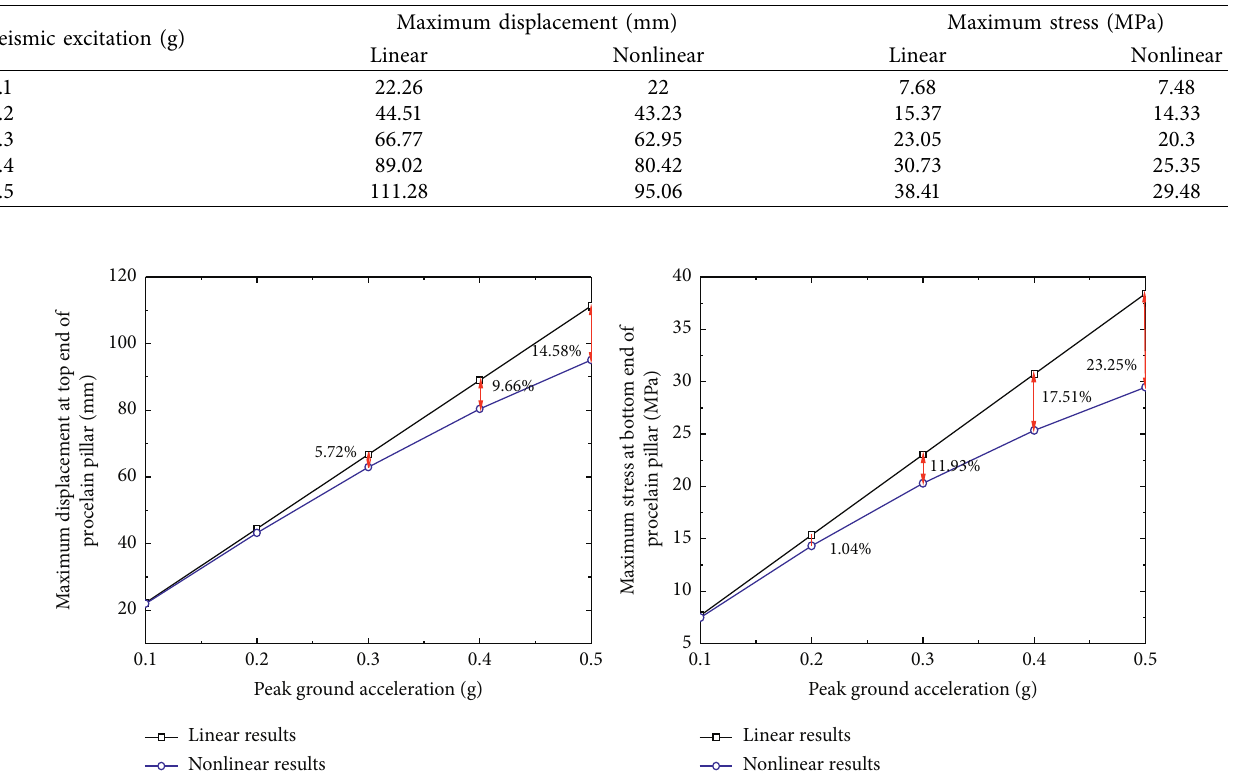
Table 2: Maximum stress and displacement of porcelain pillar.